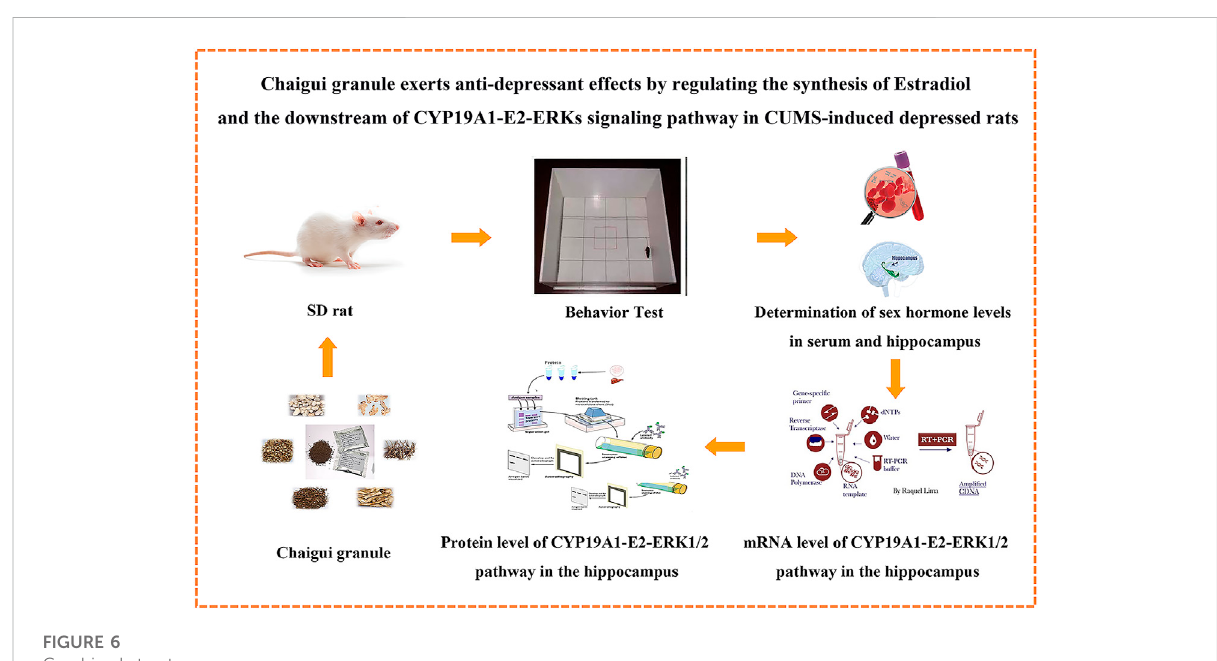
FIGURE 6 Graphic